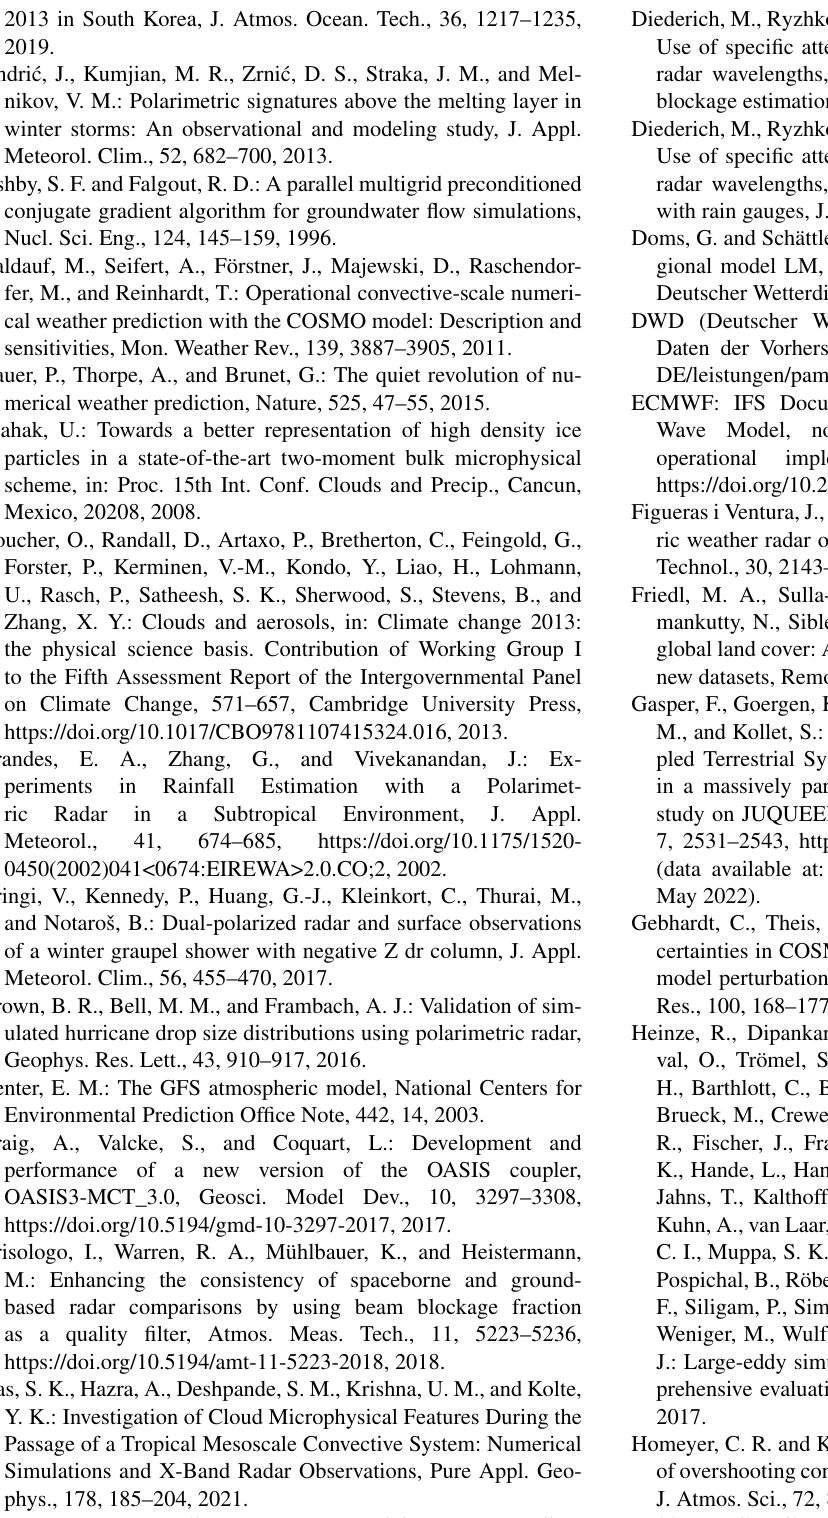
Figueras i Ventura, J., Honoré, F., and Tabary, P.: X-band